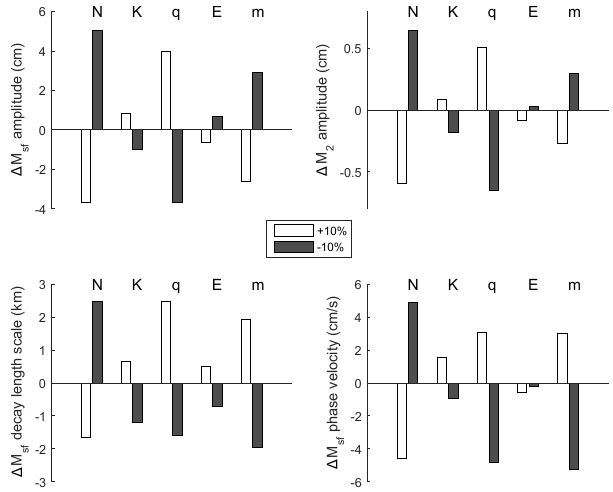
Figure 7. Sensitivity analysis of model parameters ( N , K , q , E and m ), showing change in M sf and M 2 amplitudes ( a and b ), M sf decay length scale (c) and M sf phase velocity (d) for + 10% (white bar) and − 10% (grey bar) changes in each parameter. Model outputs were compared to the simulation presented in Fig. 6 and all other parameters were kept at the values defined in that